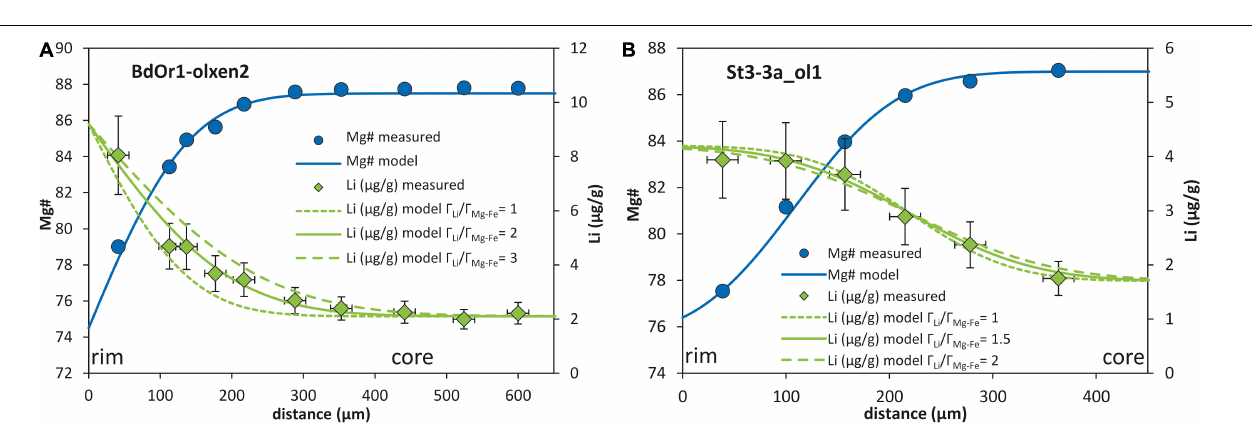
FIGURE 4 | Relative modeling of Mg# and Li ( µ g/g). The Mg# and Li profiles are fitted by adjusting Ã Mg - Fe , and Ã Li , respectively. The ratio of the Ã-values is calculated giving the relative diffusivity of Li relative to Mg–Fe, various curves for the Li profile show the variability and uncertainty in the modeled factor for relative diffusities. (A) BdOr1-olxen2 is modeled with an infinite analytical approach assuming a fixed rim concentration. The modeled profile for Li yields a factor for the Li diffusivity relative to that of the Fe–Mg exchange (indicated by Mg#) Ã Li /Ã Mg - Fe from 1 to 3, which may be considered as the uncertainty of this approach. (B) St3-3a_ol1 is modeled with a semi-infinite analytical approach assuming the equilibration of two chemically distinct layers of the crystal over time, yielding a relative diffusivity factor within an uncertainty of Ã Li /Ã Mg - Fe from 1 to 2.